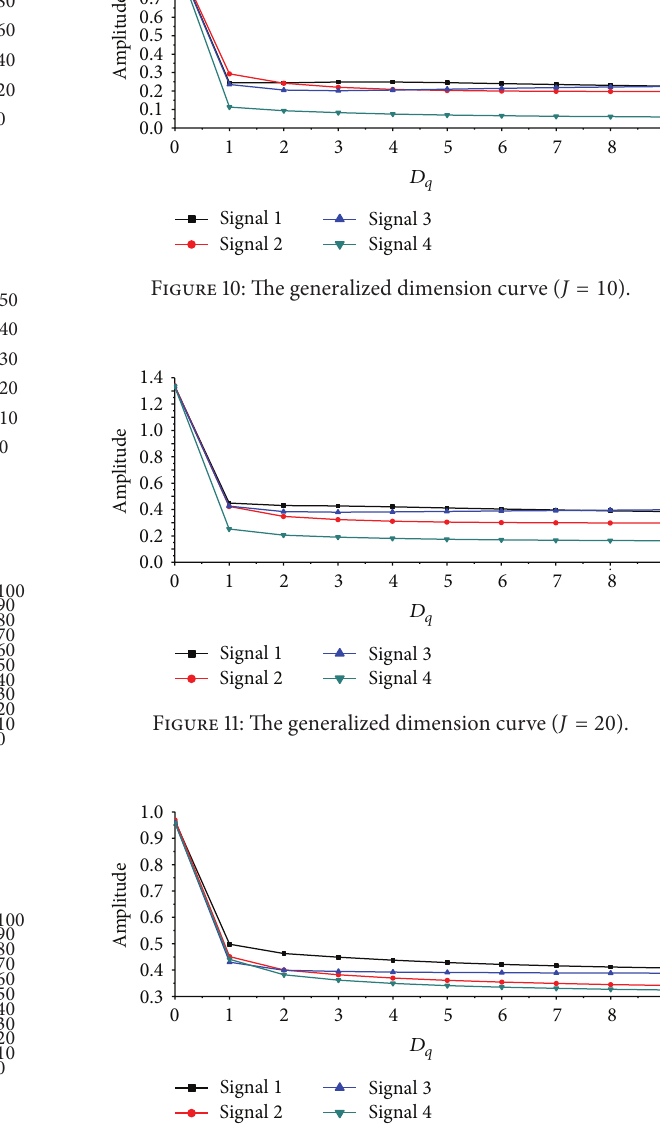
Figure 12: The generalized dimension curve ( 𝐽 = 30